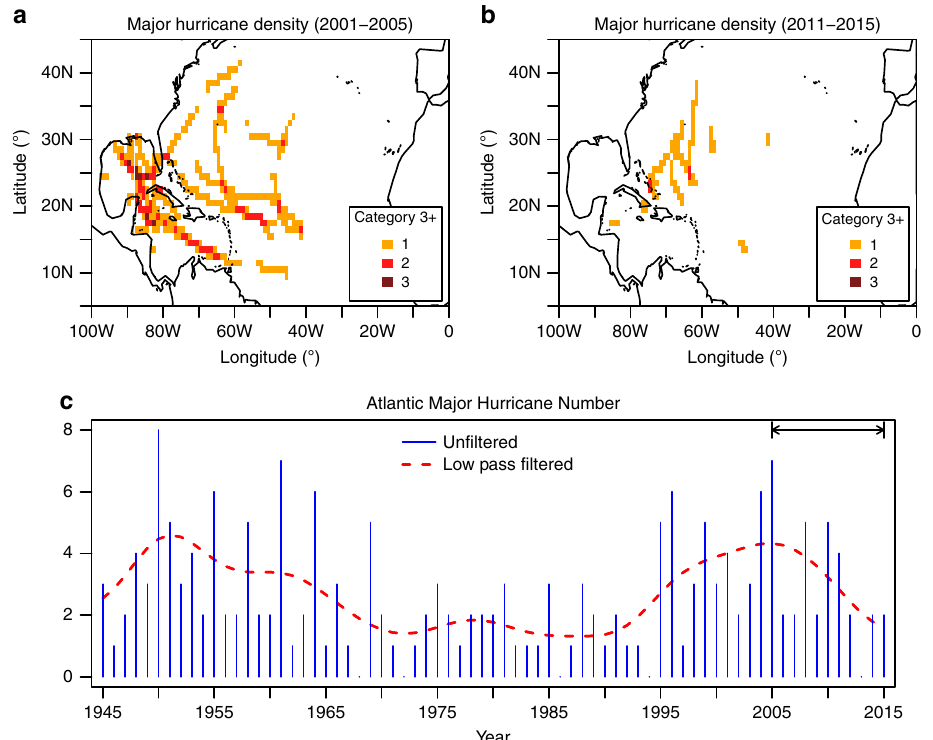
Fig. 1 Observed historical Atlantic major hurricane activity. Atlantic major hurricane track density maps are shown for ( a ) 2001 – 2005; and ( b ) 2011 – 2015; ( c ) un fi ltered Atlantic major hurricane number (blue bar) with the 10-year low-pass fi ltered time series superimposed (dashed red curve). The key focus period (2005 – 2015) is highlighted by the line segment/arrows. The track density (color shading) in ( a , b ) shows the total number of major hurricanes that occurred at each grid box within each